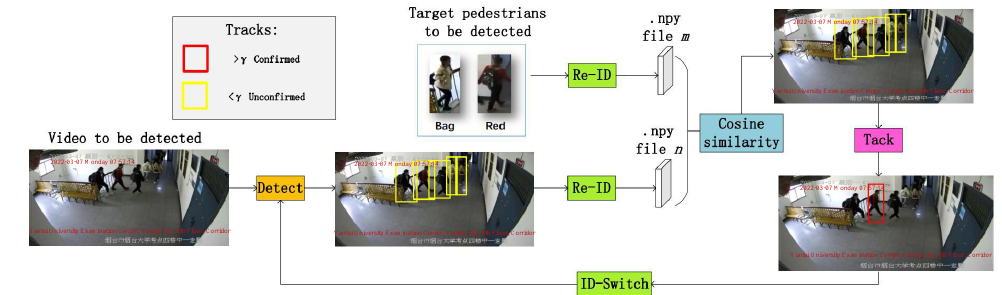
Figure 1. Overall system flow